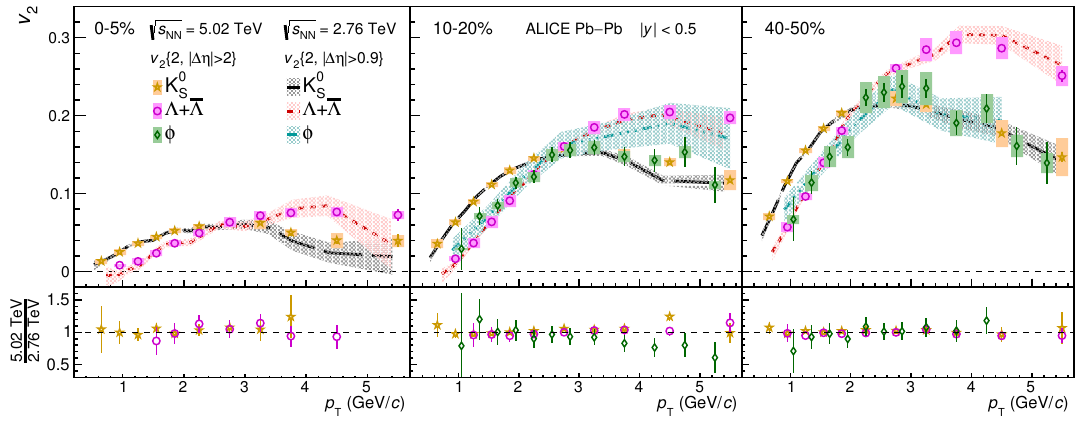
Figure 24 . (Colour online) The p T -di(cid:11)erential v 2 of (cid:3)+(cid:3), K 0 , and the (cid:30) -meson compared to AL- S p ICE measurements performed in Pb-Pb collisions at s NN = 2.76 TeV (coloured bands) [27] for the p 0{5%, 10{20%, and 40{50% centrality classes. For the measurements at s NN = 5.02 TeV, statisti- cal and systematic uncertainties are shown as bars and boxes, respectively. For the measurements p at s NN = 2.76 TeV, the thickness of the bands corresponds to the quadratic sum of statistical and p systematic uncertainties. The ratios of measurements at s NN = 5.02 TeV to a cubic spline (cid:12)t to p the measurements at s NN = 2.76 TeV are also presented for